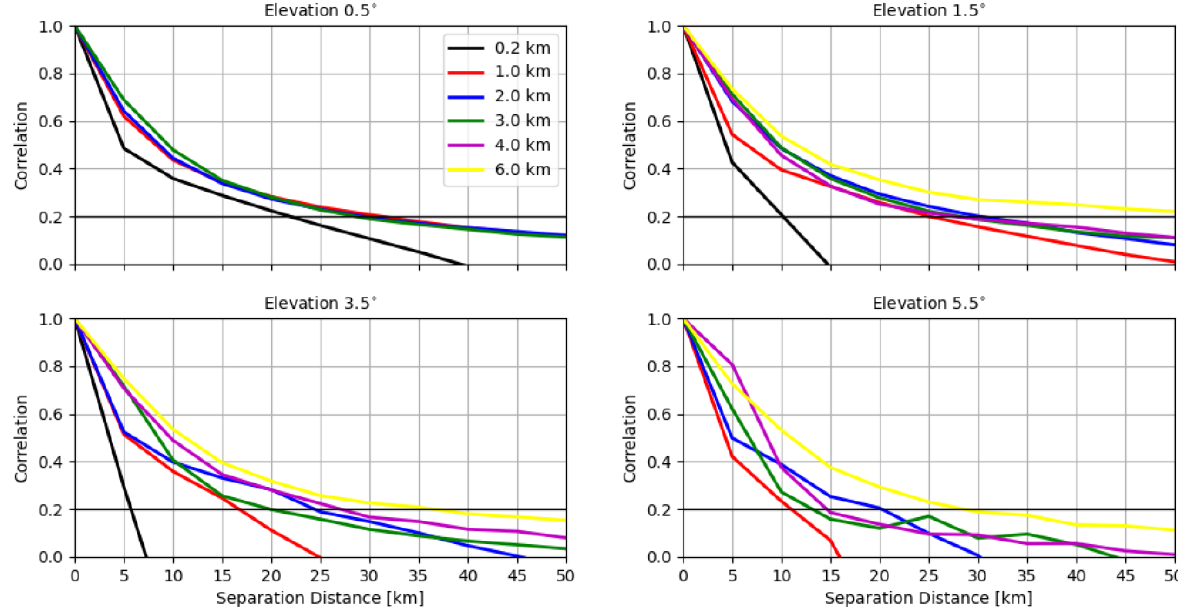
Figure 12. The same as Fig. 10 but for radial wind